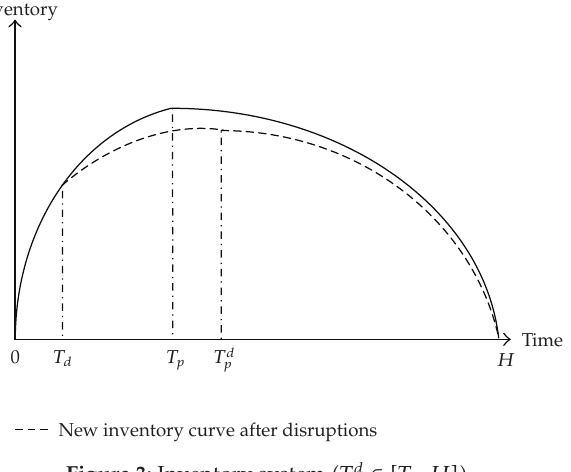
Figure 3: Inventory system (cid:5) T d